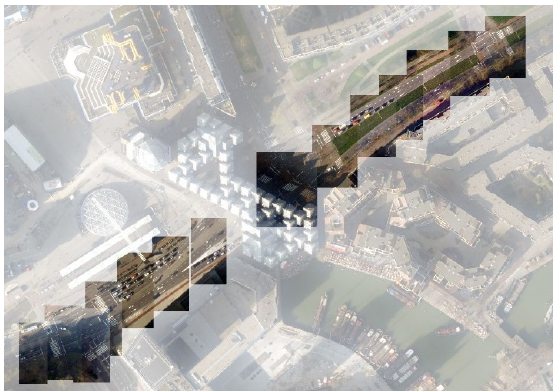
Figure 2. Test site in Rotterdam (the gap is caused by a building spanning the